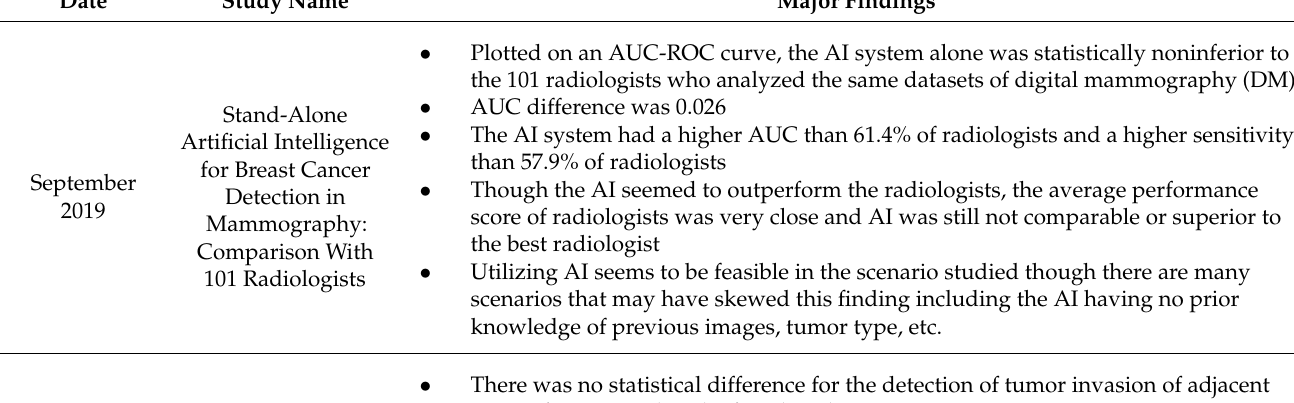
Table 1. Significant